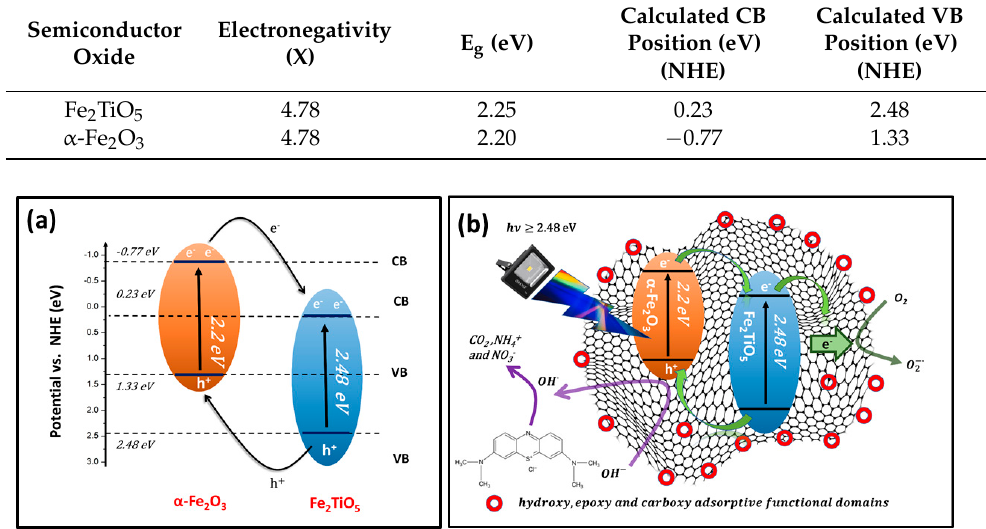
Figure 9. ( a ) Type II band alignment for Fe 2 TiO 5 and α -Fe 2 O 3 binary composite and ( b ) elucidated visible light-driven photodegradation mechanism of (0.3)r-GOTF.